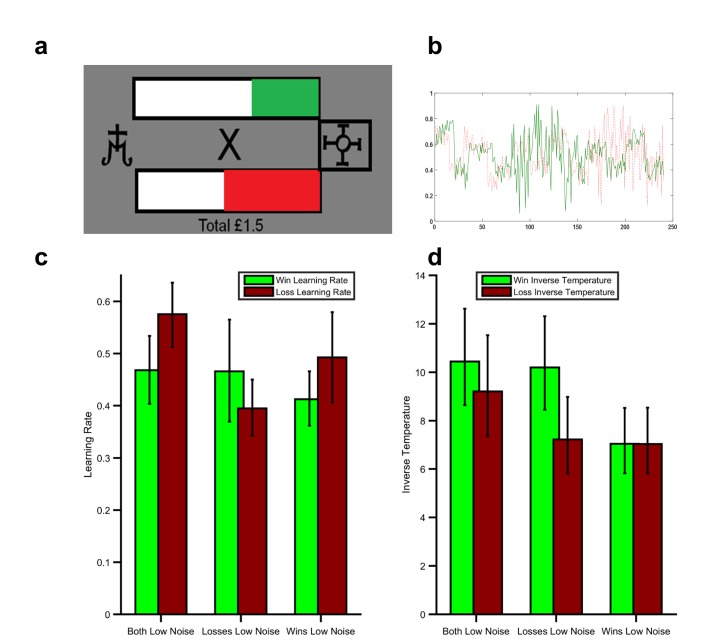
Magnitude task.When learning, a number of different forms of uncertainty can influence behaviour. One form, which is sometimes called ‘unexpected uncertainty’ (Yu and Dayan, 2005) is caused by changes in the associations being learned (i.e. volatility) and is the main focus of this paper (see main text for a description of how volatility influences learning). A second form of uncertainty, sometimes called ‘expected uncertainty’(Yu and Dayan, 2005) arises when an association between a stimulus or action and the subsequent outcome is more or less predictive. For example, this form of uncertainty is lower if an outcome occurs on 90% of the times an action is taken and higher if the outcome occurs on 50% of the time an action is taken. Normatively, expected uncertainty should influence learning rate—a less predictive association (i.e. higher expected uncertainty) leads to more random outcomes which tell us less about the underlying association we are trying to learn, so learners should employ a lower learning rate when expected uncertainty is higher. In the learning task described in this paper both the expected and unexpected uncertainty differ between blocks. Specifically, when an outcome is stable in the task it occurs on 50% of trials, whereas when it is volatile it varies between occurring on 85/15% of trials. Thus the stable outcome is, at any one time, also less predictable (i.e. noisier) than the volatile outcome. This task schedule was used as a probability of 50% for the stable outcome improves the ability of the task to accurately estimate learning rates (it allows more frequent switches in choice). Further both forms of uncertainty would be expected to reduce learning rate in the stable blocks and increase it in the volatile block of the task. However, this aspect of the task raises the possibility that the observed effects on behaviour described in the main paper may arise secondary to differences in expected uncertainty (noise) rather than the unexpected uncertainty (volatility) manipulation. In order to test this possibility we developed a similar learning task in which volatility was kept constant and expected uncertainty was varied. In this magnitude task (panel a), participants again had to choose between two shapes in order to win as much money as possible. On each trial 100 ‘win points’ (bar on top of fixation cross with green fill) and 100 ‘loss points’ (bar under fixation cross with red fill) were divided between the two shapes and participants received money proportional to the number of win points – loss points of their chosen option. Thus, a win and loss outcome occurred on every trial of this task, but the magnitude of these outcomes varied. During the task, participants had to learn the expected magnitude of wins and losses for the shapes rather than the probability of their occurrence. This design allowed us to present participants with schedules in which the volatility (i.e. unexpected uncertainty) of win and loss magnitudes was constant (three change points occurred per block) but the noise (expected uncertainty) varied (Panel b; the standard deviation of the magnitudes was 17.5 for the high noise outcomes and 5 for the low noise outcomes). Otherwise the task was structurally identical to the task reported in the paper with 240 trials split into three blocks. We recruited a separate cohort of 30 healthy participants who completed this task and then estimated their learning rate using a model which was structurally identical (i.e. two learning rates and two inverse temperature parameters) to that used in the main paper (Model 1). As can be seen (Panel c), there was no effect of expected uncertainty on participant learning rate (block information x parameter valence; F(1,28)=1.97, p=0.17) during this task. This suggests that the learning rate effect reported in the paper cannot be accounted for by differences in expected uncertainty and therefore is likely to have arisen due to the unexpected uncertainty (volatility) manipulation. Inverse decision temperature did differ between block (Panel d; F(1,28)=5.56, p=0.026). As can be seen there was a significantly higher win inverse temperature during the block in which the losses had lower noise (F(1,28)=9.26,p=0.005) and when compared to the win inverse temperature when wins had lower noise (F(1,28)=5.35,p=0.028), but no equivalent effect for loss inverse temperature. These results indicate that, if anything, participants were more influenced by noisy outcomes. Interestingly a previous study (Nassar et al., 2012) described a learning tasks in which a normative effect of outcome noise was seen (i.e. a higher learning rate was used by participants when the outcome had lower noise). The task used by Nassar and colleagues differed in a number of respects to that used here (only rewarding outcomes were received and participants had to estimate a number on a continuous scale, based on previous outcomes rather than make a binary choice) which may explain why an effect on learning rate was not observed in the current task. Regardless of the exact reason for the lack of effect of noise in the magnitude task, it suggests that the effect described in the main paper is likely to be driven by an effect of unexpected rather than expected uncertainty.